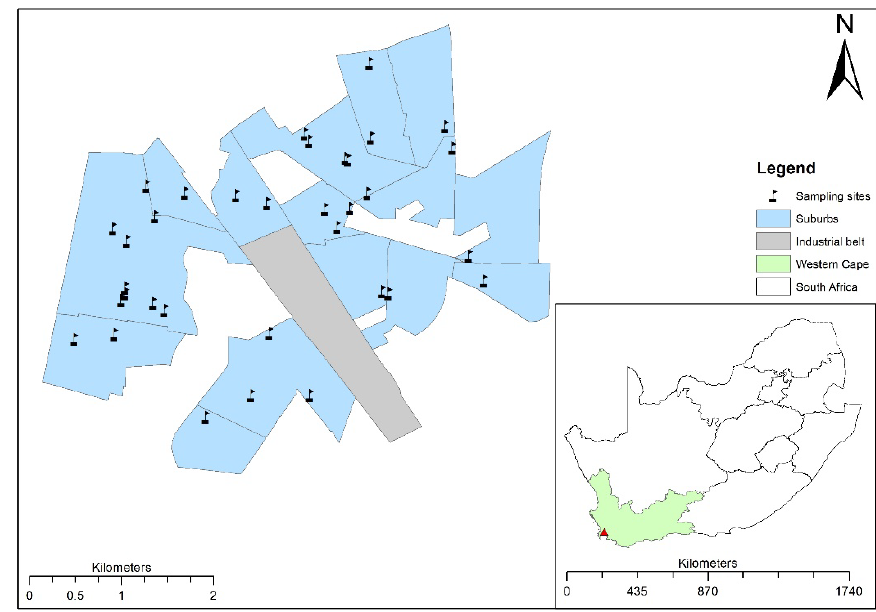
Figure 1. Location of sampled preschools in relation to the industrial zone.